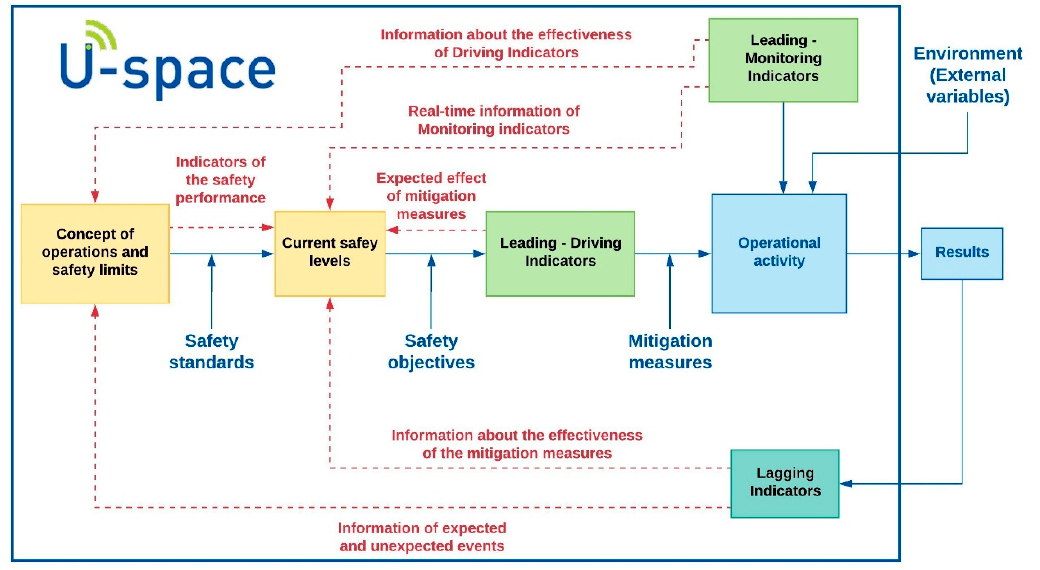
Figure 3. Proposed U-space safety framework.